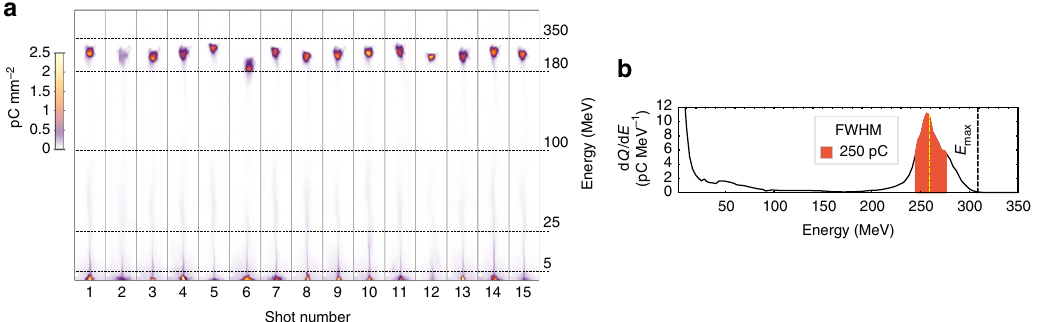
Fig. 1 Energy spectra of 15 consecutive shots. a Raw energy electron spectra. The color map represents the charge density (pC mm − 2 ) on the detector. b Energy spectrum of the fi rst shot from a . The fi lled area represents the charge within the FWHM, the yellow dashed line represents the mean peak energy and the black dashed line represents the maximum attained energy ( E max ) at 0.1 pC MeV − 1 . Obtained with a supersonic gas jet with a 1.6 mm-long plasma density plateau of 3.1 × 10 18 cm − 3 , 1% nitrogen doping and 2.5 J laser energy in 30 fs FWHM duration. Line graphs of all shots shown in ( a ) can be found in Supplementary Fig. 2 NATURE COMMUNICATIONS | 8: 487 | DOI: 10.1038/s41467-017-00592-7 |